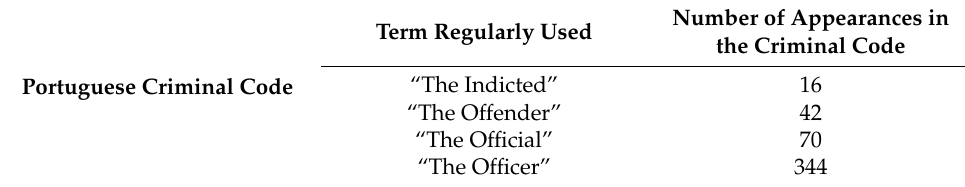
Table 1. Terms Enumeration in the Portuguese Criminal Code. Source: own elaboration. Number of Appearances in Term Regularly Used the Criminal Code “The Indicted” 16 Portuguese Criminal Code “The Offender” 42 “The Official” 70 “The Officer” 344 Source: own